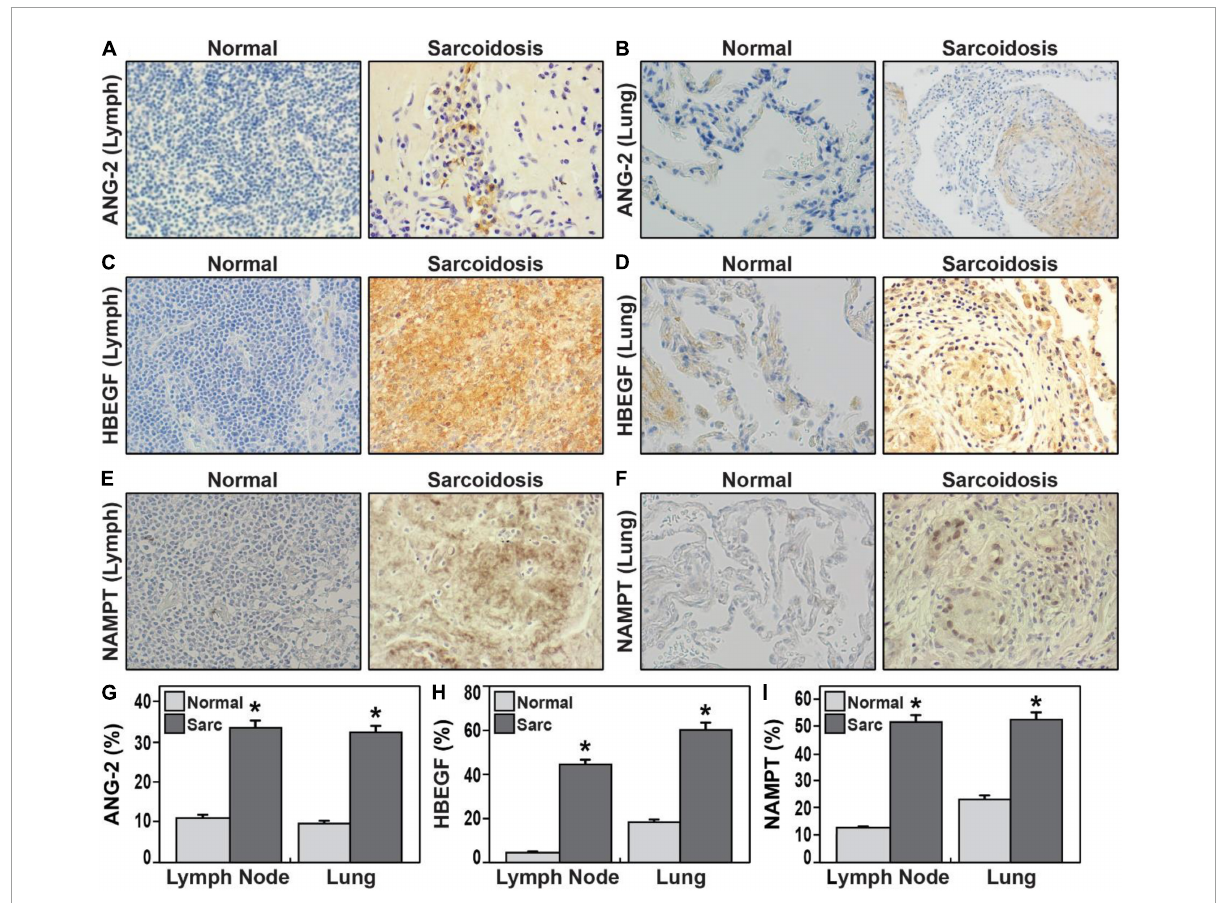
FIGURE4 (A–F) Representative immunohistochemical staining of lymph nodes (A,C,E) and lung tissues (B,D,F) from sarcoidosis compared healthy controls 40 × magnification. ANG-2 (A,B,G) , HBEGF (C,D,H) , NAMPT (E,F,I) . (G–I) Bar graphs (G) illustrate quantification of mean proportions of ANG-2, HBEGF, and NAMPT * p < 0.05. Sarcoidosis in dark gray and normal tissue in light gray. ANG-2 expression in lung tissue and lymph node in sarcoidosis was 32.2 and 33.7%, respectively, in contrast to the expression observed in normal lung and lymph nodes was 9.8 and 11.3%, respectively ( p = 1.2 e-04). HBEGF expression in sarcoidosis lymph nodes was 44.8% vs. 4.8% in normal lymph nodes ( p = 3.8 e-05); in normal lungs was 18.3% contrasting with 60.4% in lung of sarcoidosis ( p = 4.0 e-05). NAMPT mean proportions in lymph nodes were 12.7% in normal tissue and 52% in sarcoidosis ( p = 4.9 e-04); while in normal lungs was 23.3% vs. 53% in sarcoidosis ( p = 9.2 e-040. in lymph